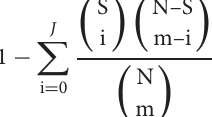
TABLE 1 | Susceptibility genes by using more stringent p -Values and the intersection of VEGAS2 and PLINK in AQP4-positive NMOSD. Gene set